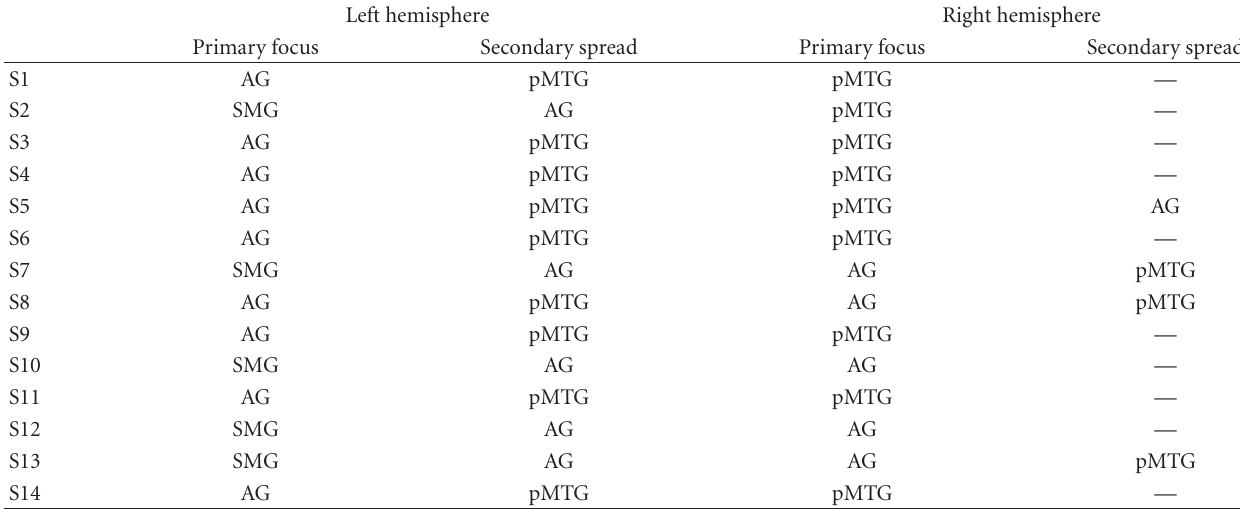
Table 3: Regions of primary focus and secondary spread for parietal ROIs associated with the NEW condition in each of the 14 subjects. Left hemisphere Right